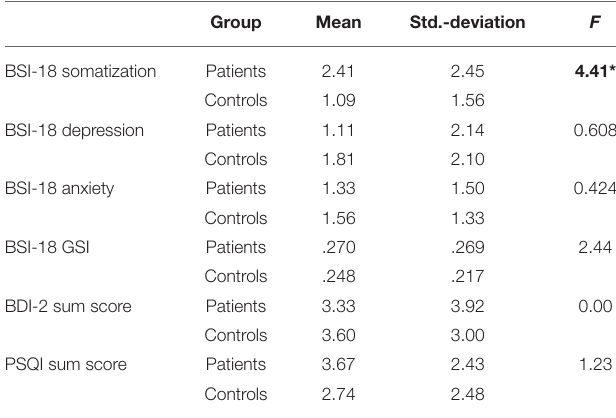
TABLE 2 | Means and standard deviations in BSI subscales, BSI GSI, BDI-2, and PSQI in patients and